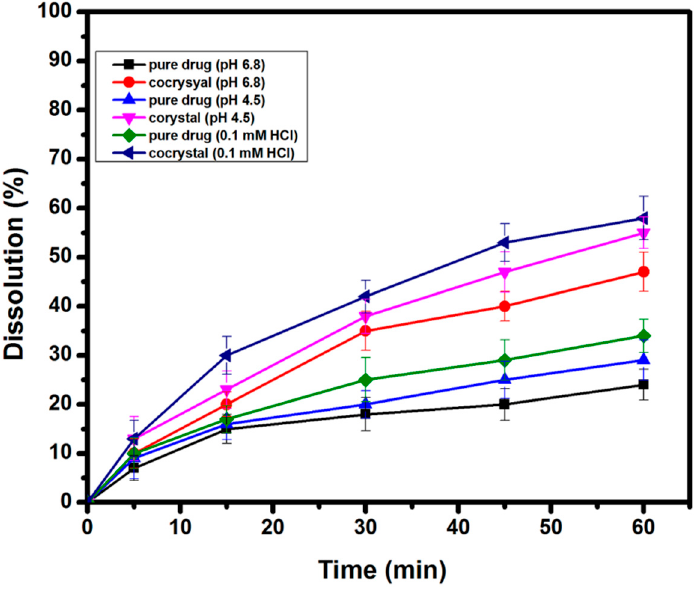
Figure 8. Powder dissolution rate of AZT DH and cocrystal in different dissolution medium.